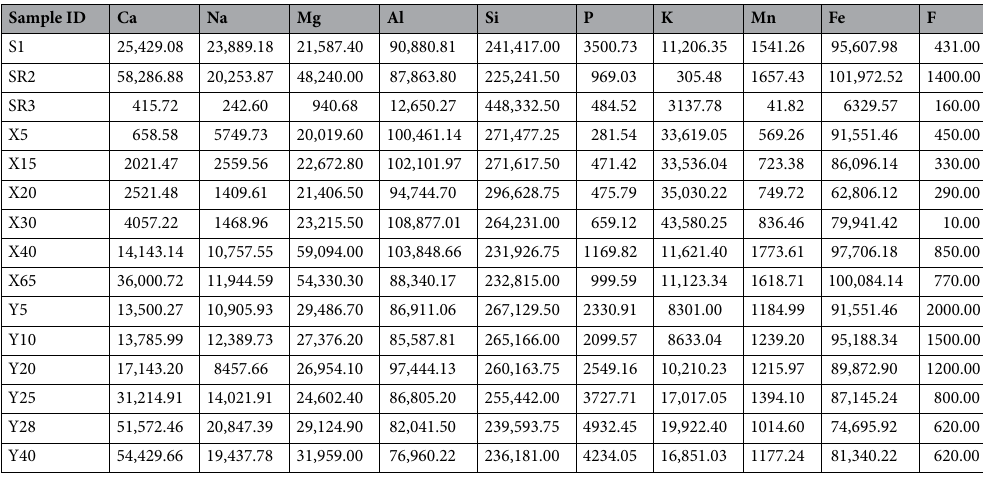
Table 6. Major elemental compositions of rocks and soils (mg/kg) in the study area. S surface soil, SR surface rock, X borehole BH1 depth, Y borehole BH2 depth, ion units, mg/kg depth: m.